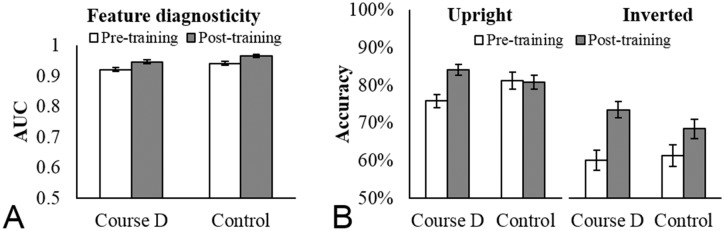
Qualitative measures of facial image comparison expertise before and after training.(A) The extent to which facial feature similarity ratings predict same/different identities (AUC) for Course D trainees from a UK police service and control participants at pre- and post-training. (B) Accuracy on the inversion test at pre- and post-training for Course D trainees and control participants. Course D trainees and control participants show equivalent feature diagnosticity and inversion effects, indicating that Course D did not produce the qualitative indicators of facial image comparison expertise. Error bars show within-subjects corrected standard error of the mean [21].